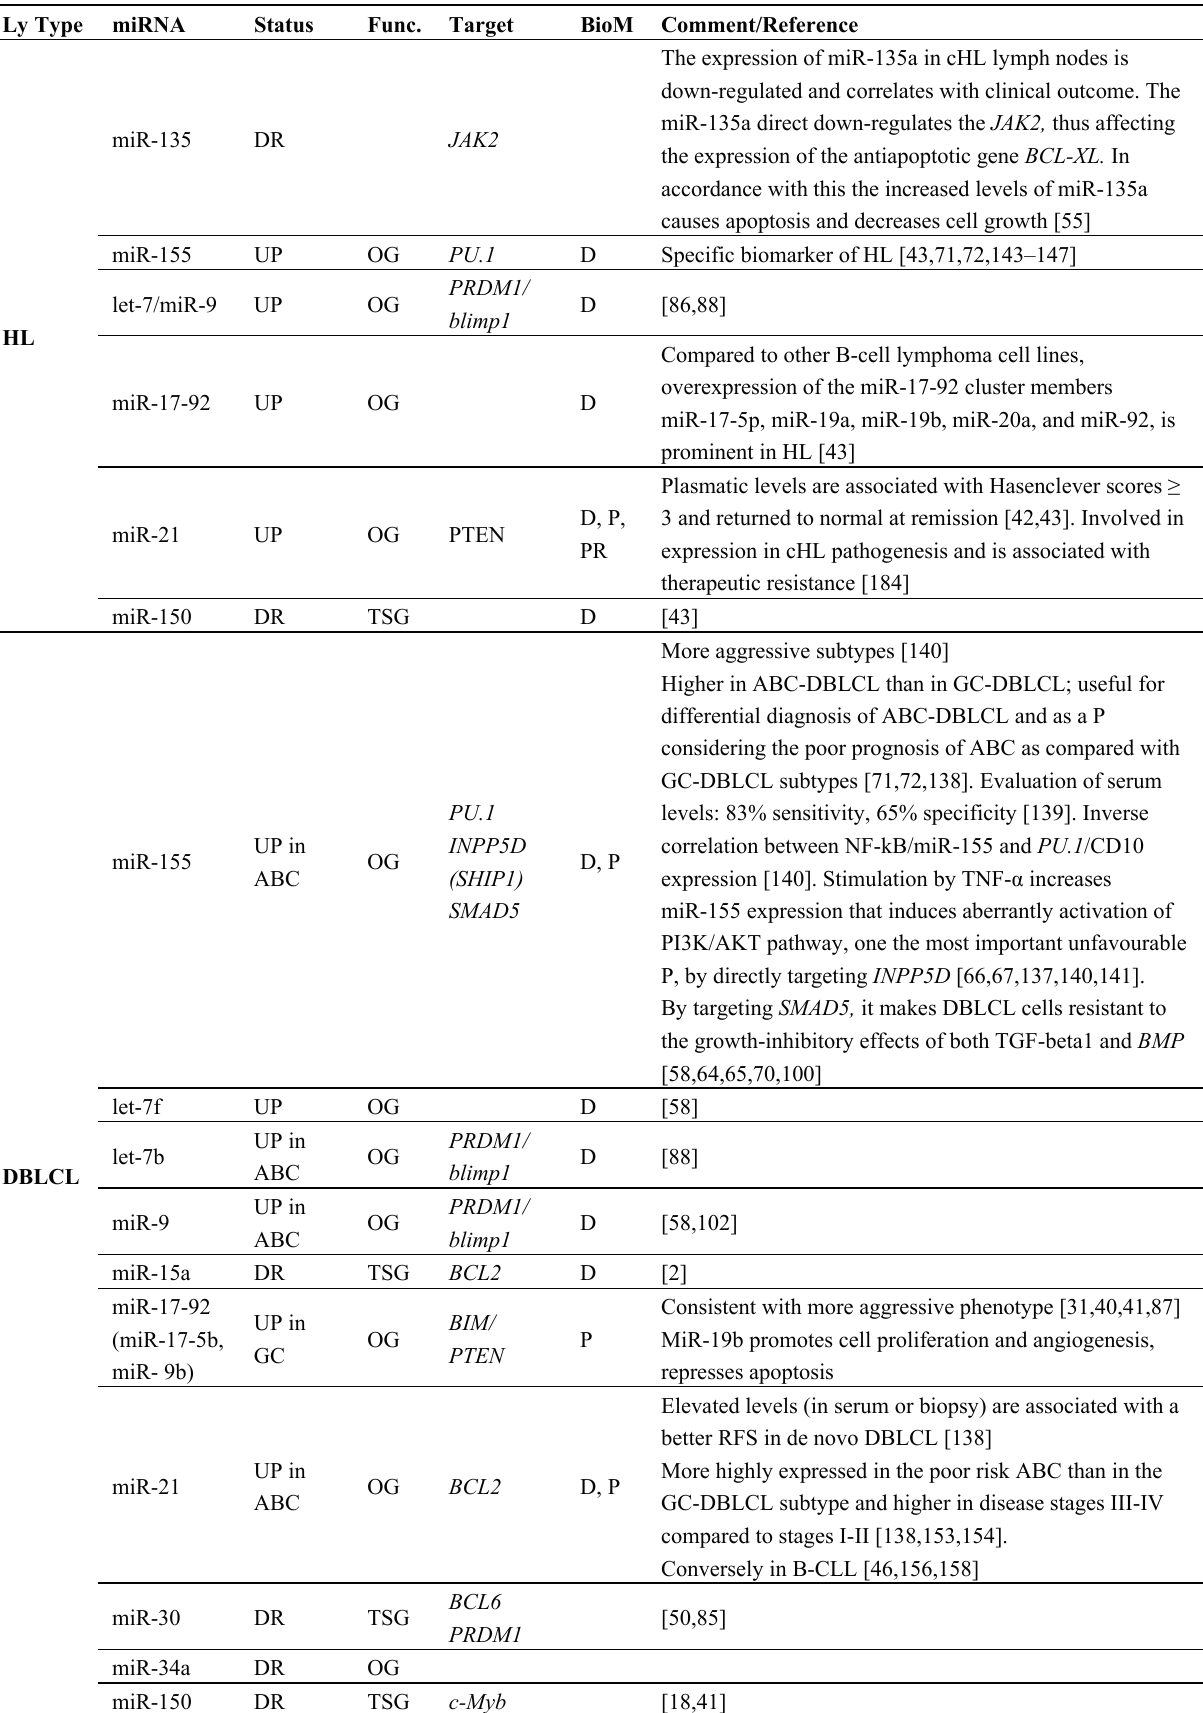
Table 3. Summary of miRNAs involved in lymphoma